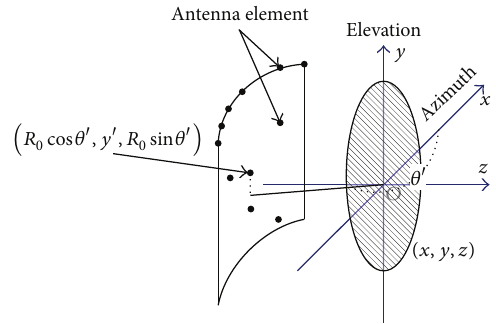
Figure 1: Cylindrical near-field 3D imaging configuration.